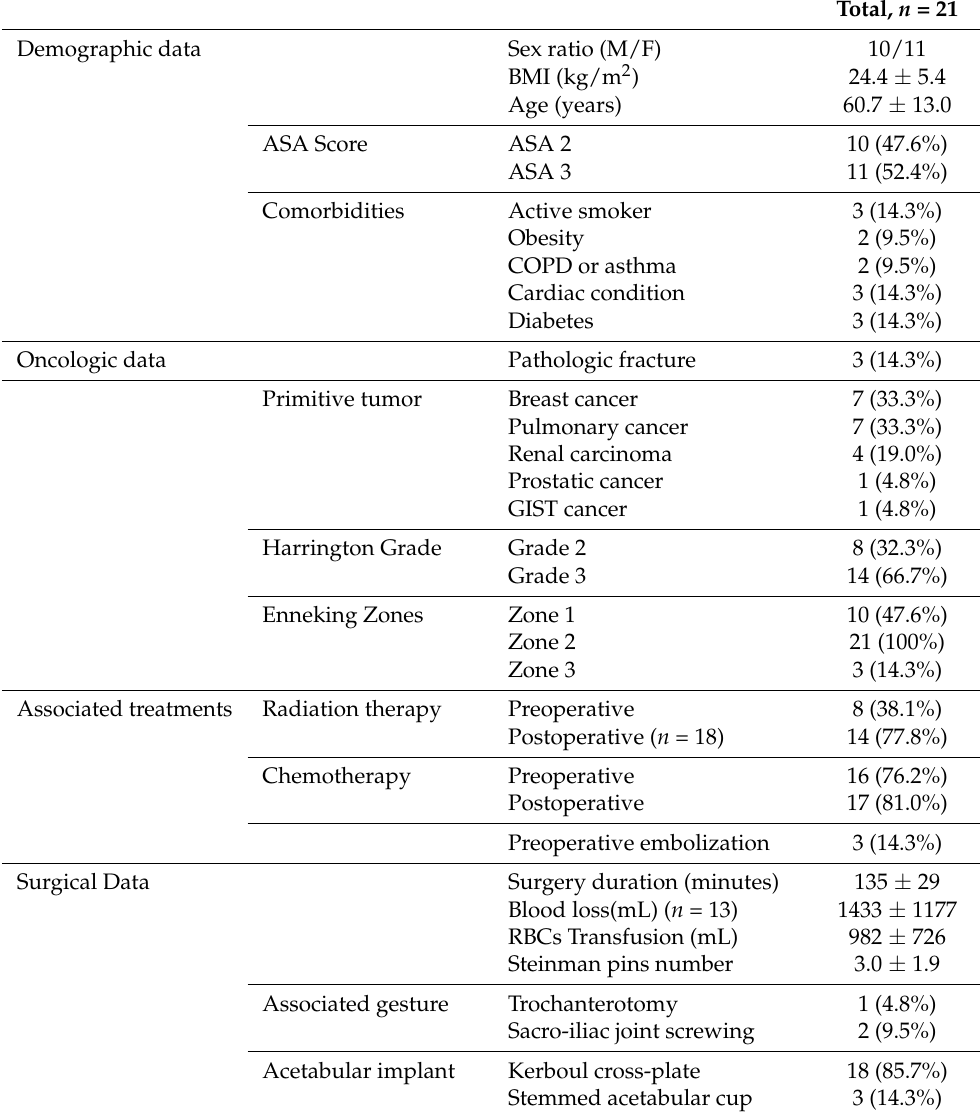
Table 1. Population